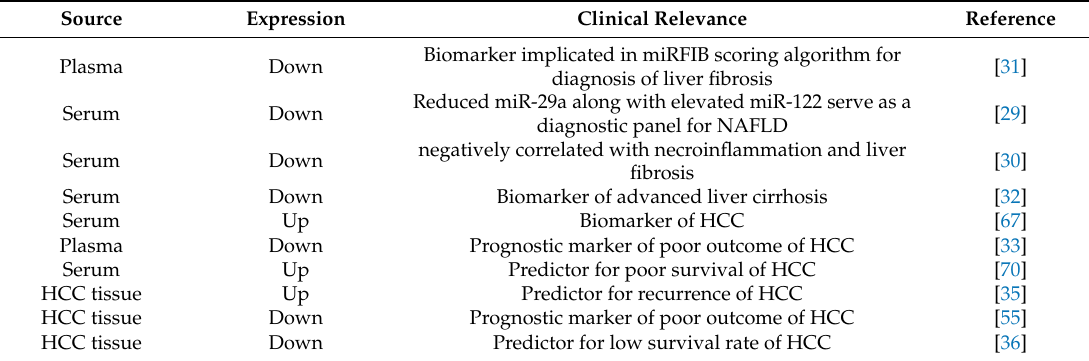
Table 3. Clinical Relevance of miR-29a in the Diagnosis of Liver